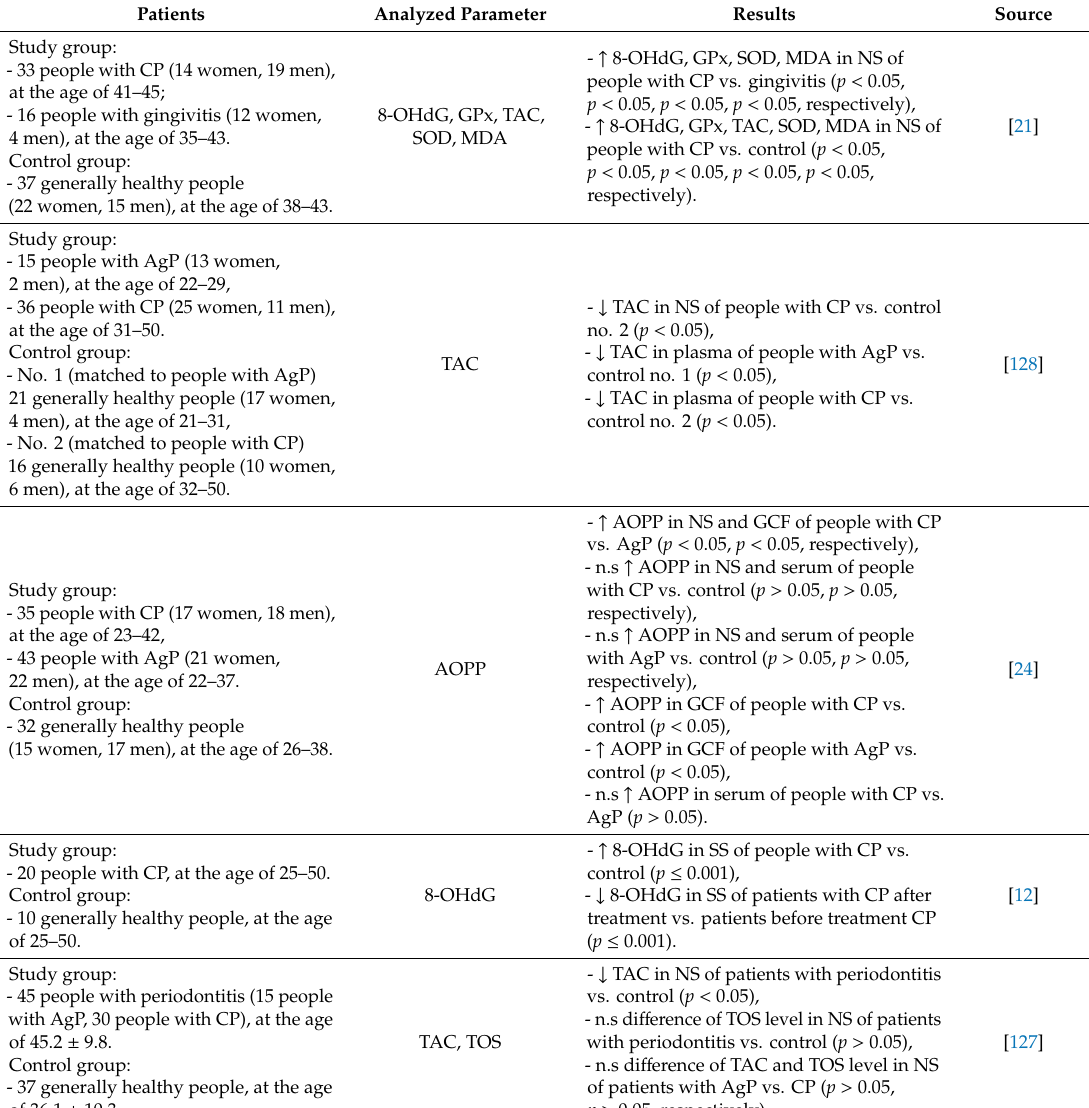
Table 2. Results of OS parameters in patients with